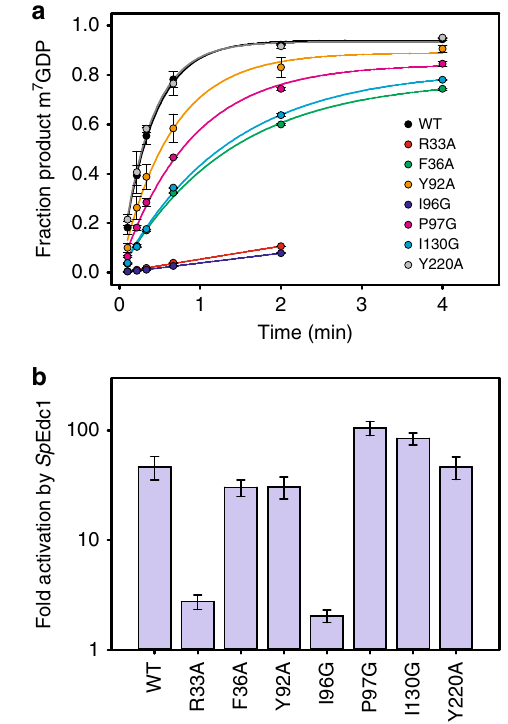
Fig. 2 Mutations on both the Dcp2 NRD and fl exible hinge prevent activation by Edc1. a In vitro decapping timecourses for Sp Edc1 – Dcp1 – Dcp2 WT and Dcp2 mutant complexes. R33A and I96G mutations completely block activation of Dcp1 – Dcp2 by Edc1 peptide. Concentration of Dcp1 – Dcp2(1 – 243) is 2 µ M and Edc1(155 – 180) peptide is 100 µ M. Errors are s.d. of two independent replicates. b Fold activation of WT and Dcp2 mutant decapping complexes by Edc1 peptide. Calculated as k – Dcp1 – Dcp2)/ k – Dcp2). k – Dcp2 with obs (Edc1 obs (Dcp1 obs values for Dcp1 no Edc1 coactivator peptide are shown in Supplementary Fig. 4. Errors are s.